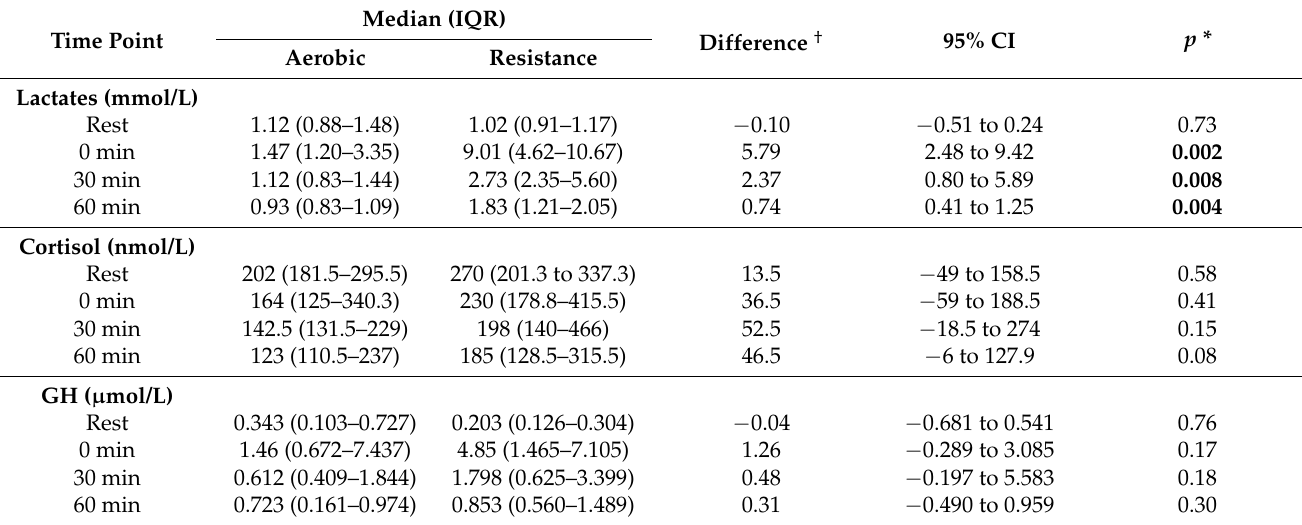
Table 6. Lactate, cortisol, and GH response to aerobic versus resistance training.